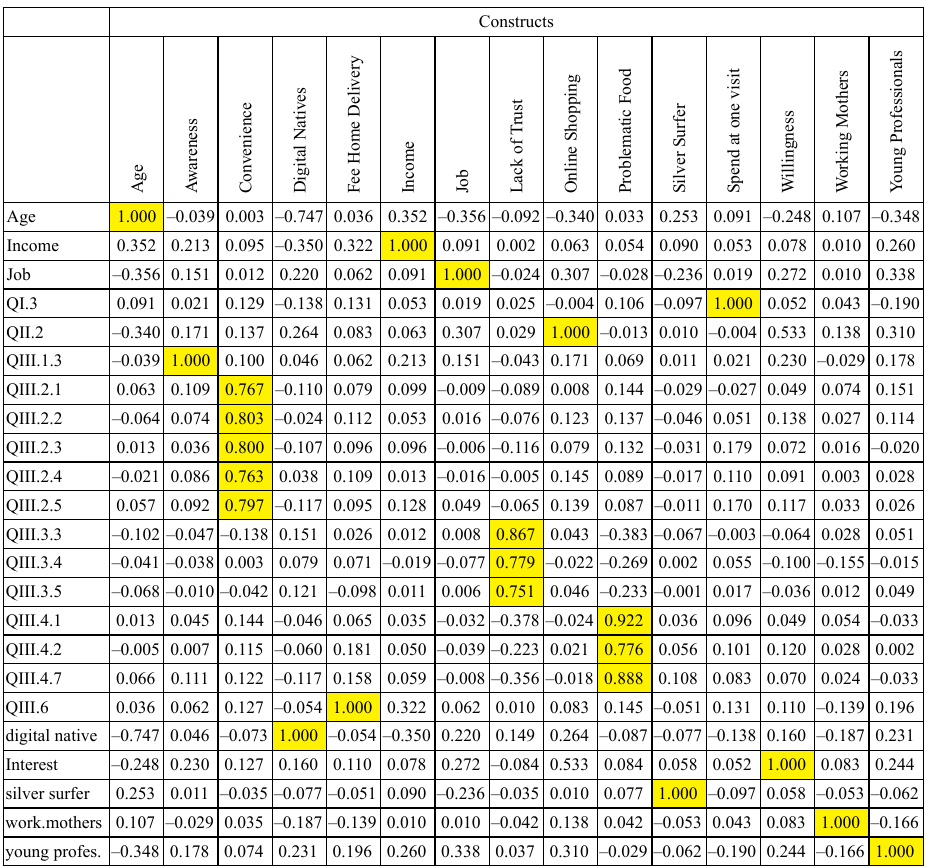
Table 3. Cross-loadings of the PLS-SEM